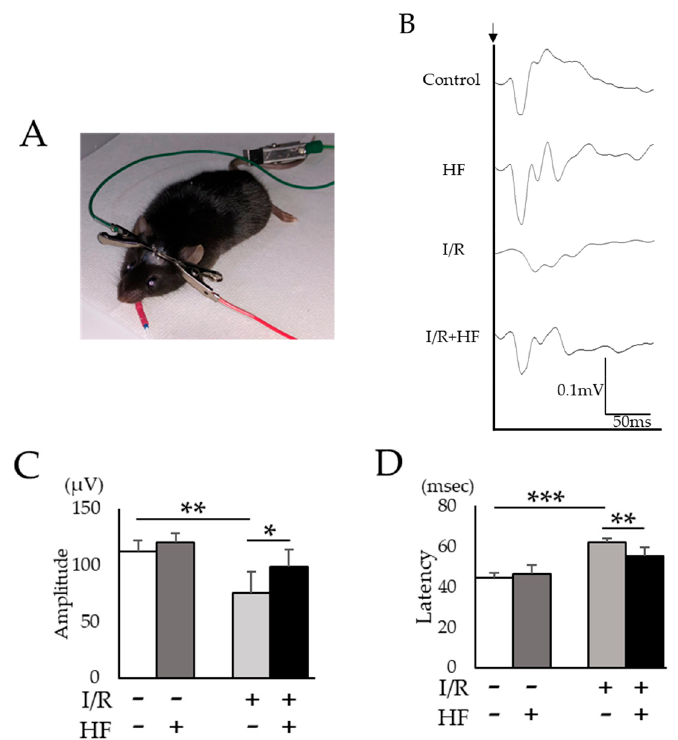
Figure 7. Evaluation of visual function detected with visual evoked potential (VEP). ( A ) A representative photograph of VEP recording. ( B ) Representative VEP waveforms from control and post-I / R retina with or without halofuginone treatment. A black arrow indicates the timing of the light stimulation. ( C ) The average of VEP amplitudes ( n = 4). Note that decrease of VEP amplitude was suppressed by halofuginone administration. ( D ) The average of VEP implicit time ( n = 4). The prolonged latencies by I / R injury were prevented in halofuginone-treated group. Error bars indicate the standard deviation. HF; halofuginone. * p < 0.05, ** p < 0.01, *** p < 0.001, Student’s t -test